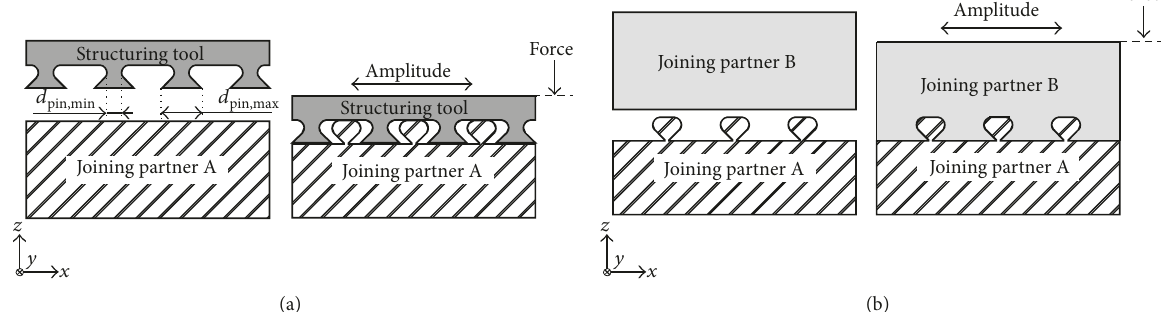
Figure 1: Process idea of joining incompatible polymer combinations by form fit using the vibration welding process. (a) Prestructuring process of joining partner A. (b) Welding process of joining partner A and joining partner